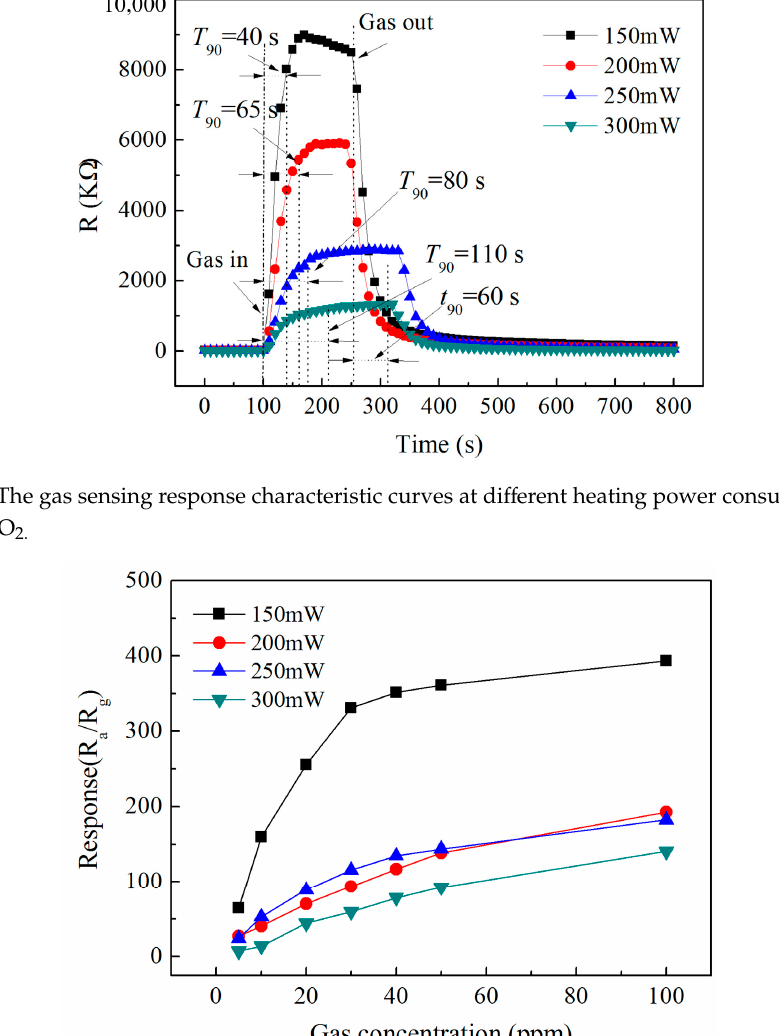
Figure 12. Variation of the response to NO 2 with the gas concentration at different power consumptions.